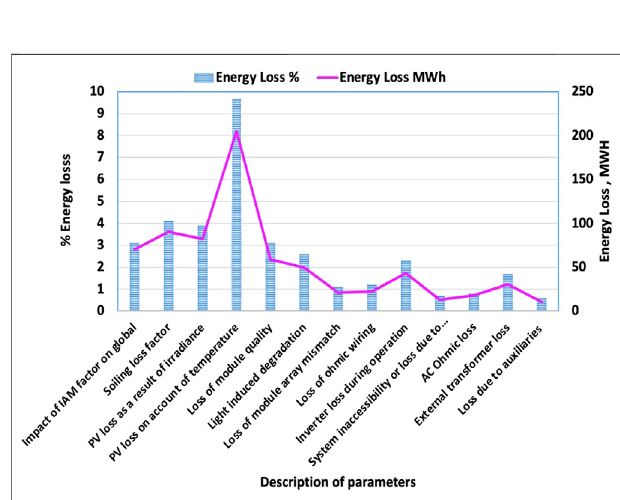
FIGURE 4 | Energy loss estimation of PV